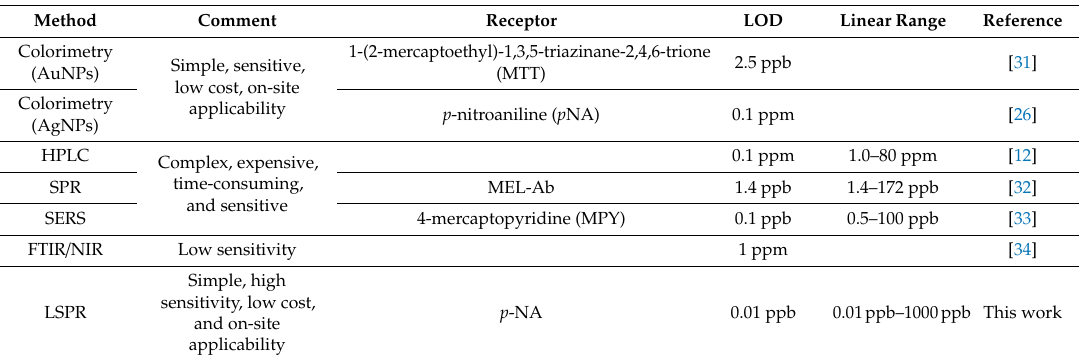
Figure 3. Specific melamine detection in infant formulas. ( a ) The change of the plasmon spectrum and ( b ) the linear correlation with the melamine concentration in melamine-spiked infant formulas. All experiments were performed with five measurements, and the data represent mean ± standard deviation. The coefficient of variation (% CV) is below 10%. Table 1. Limits of detection (LODs) of various melamine analytical methods in infant formula.